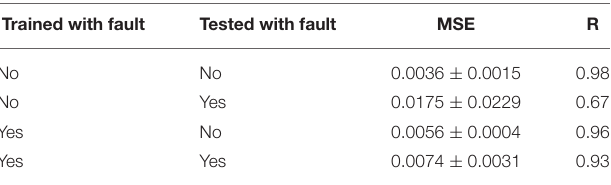
TABLE 2 | Mean and standard deviation of MSE in testing evaluated on all legs when the training and testing phase is performed in presence of faults as discussed in the text.